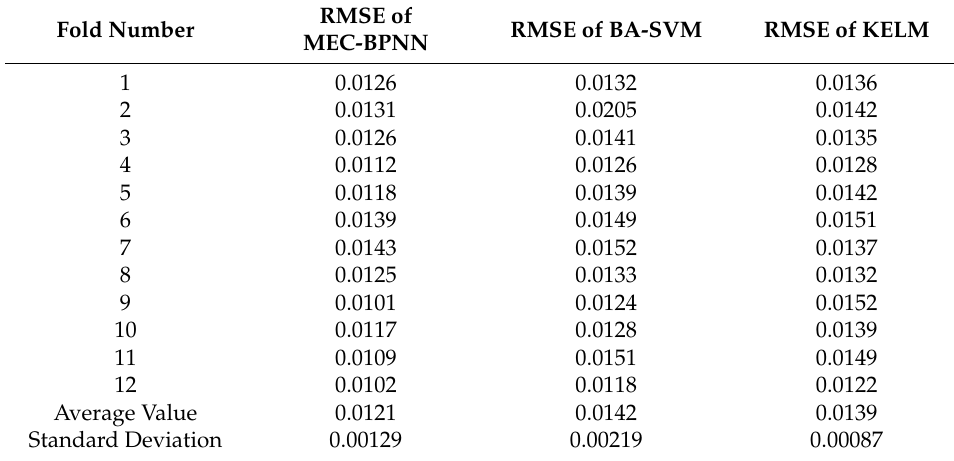
Table 2. Results of the k-fold cross